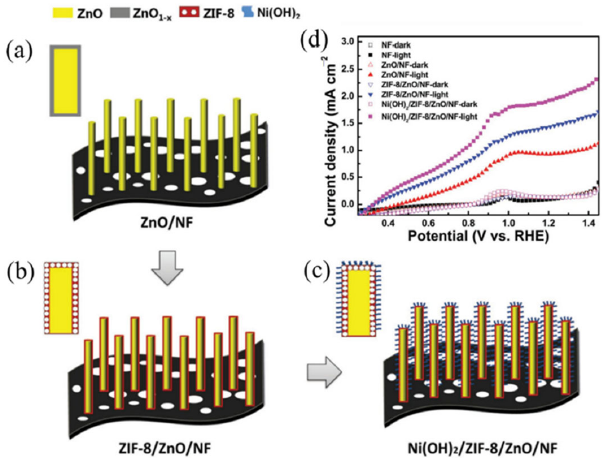
Figure 5. ( a – c ) Schematic illustration of the fabrication processes of Ni(OH) 2 /ZIF ‐ 8/ZnO/NF pho ‐ toanode. The inset depicts the variation of surface chemistry. ( d ) LSV curves for typical photoanodes (Ni(OH) 2 /ZIF ‐ 8/ZnO/NF, ZIF ‐ 8/ZnO/NF, ZnO/NF, NF) in the dark and under AM 1.5 G irradiation in 0.1 M KOH electrolyte. Reproduced from [62] with permission.